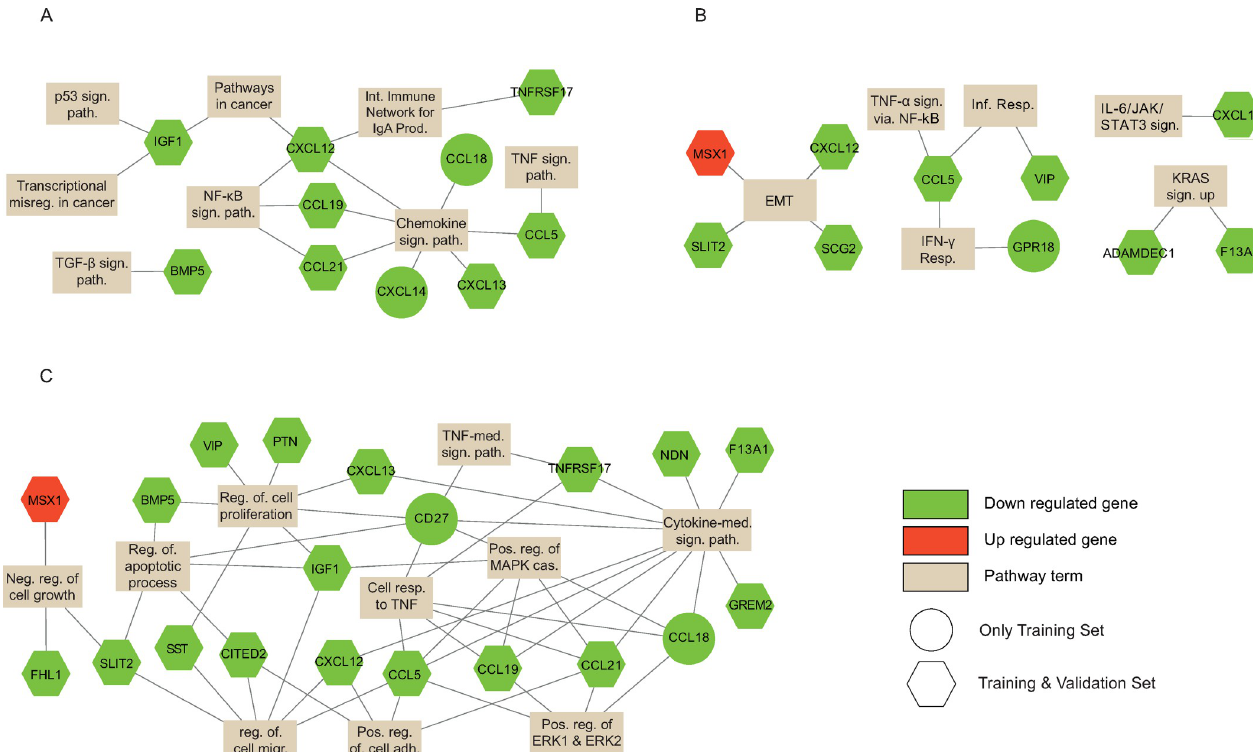
Fig 4. The gene-term graph in which the up / down regulated genes of the terms that are significant terms (A. KEGG pathway, B. Cancer Hallmark term, and C. GO-BP) for the 3 rd module of the FN algorithm.